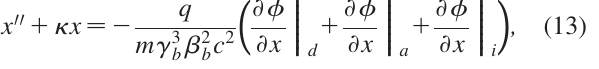
with the direct, applied, and image field components speci- fied in Eq. (12). For the case of a sheet beam in free space, the applied and image components are set to zero.